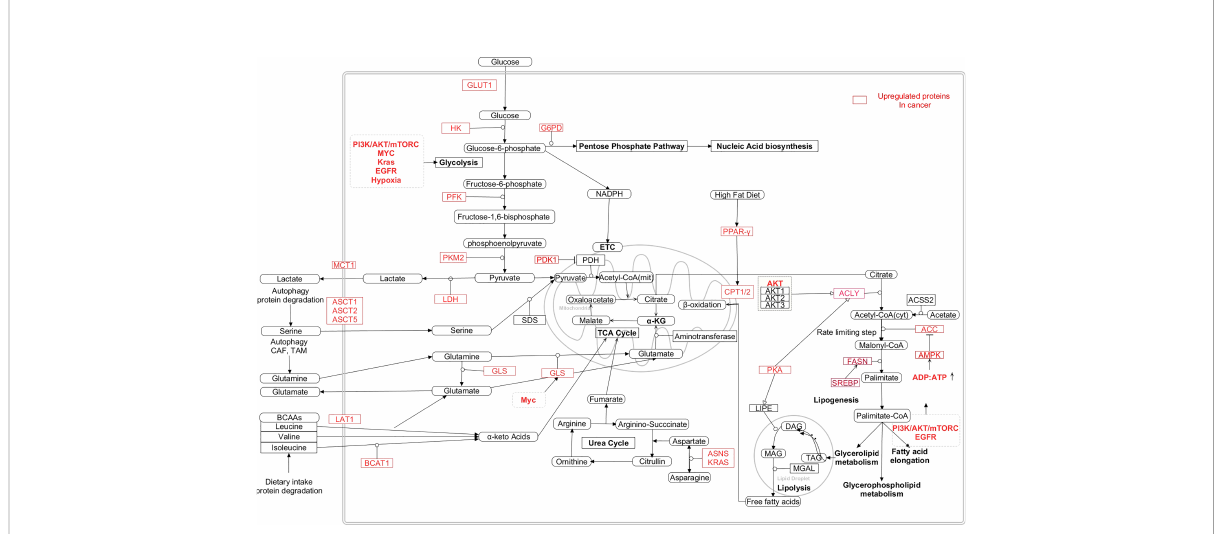
FIGURE 5 Interaction between the metabolic pathways and the dysregulated metabolic intermediates in cancer cells (24, 235 – 241). [HK: Hexokinase, PFK: Phosphofructokinase, PKM2: Pyruvate kinase M2, LDH: Lactate dehydrogenase, PDK1:Pyruvate dehydrogenase kinase 1, PDH: